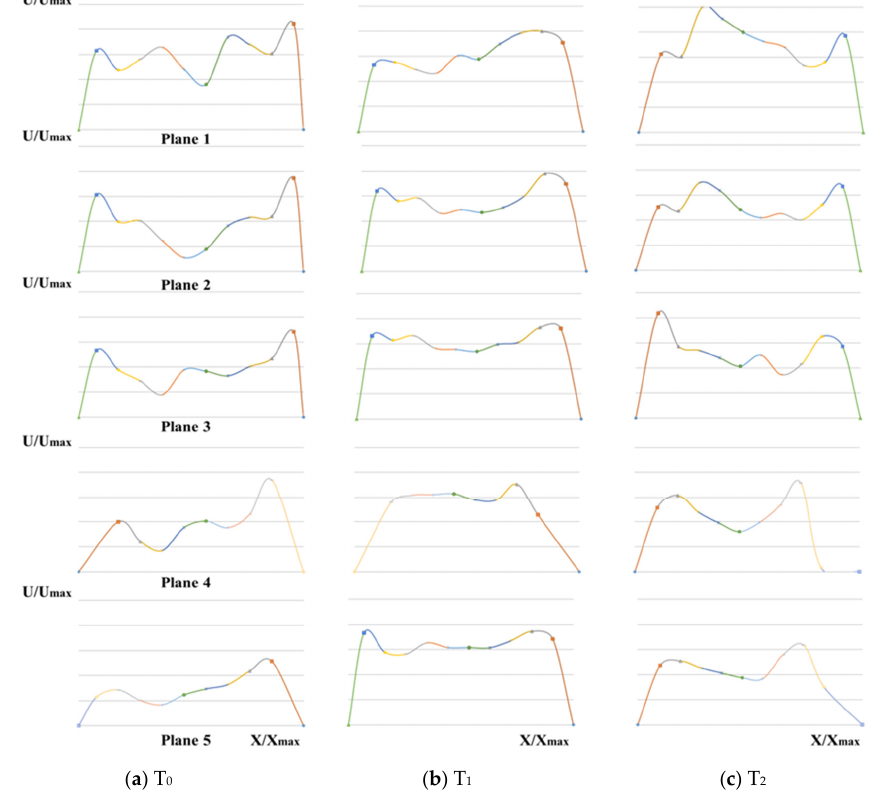
Figure 8. Velocity profile in patient 7 between planes 1–5 (t = 1.25 s).